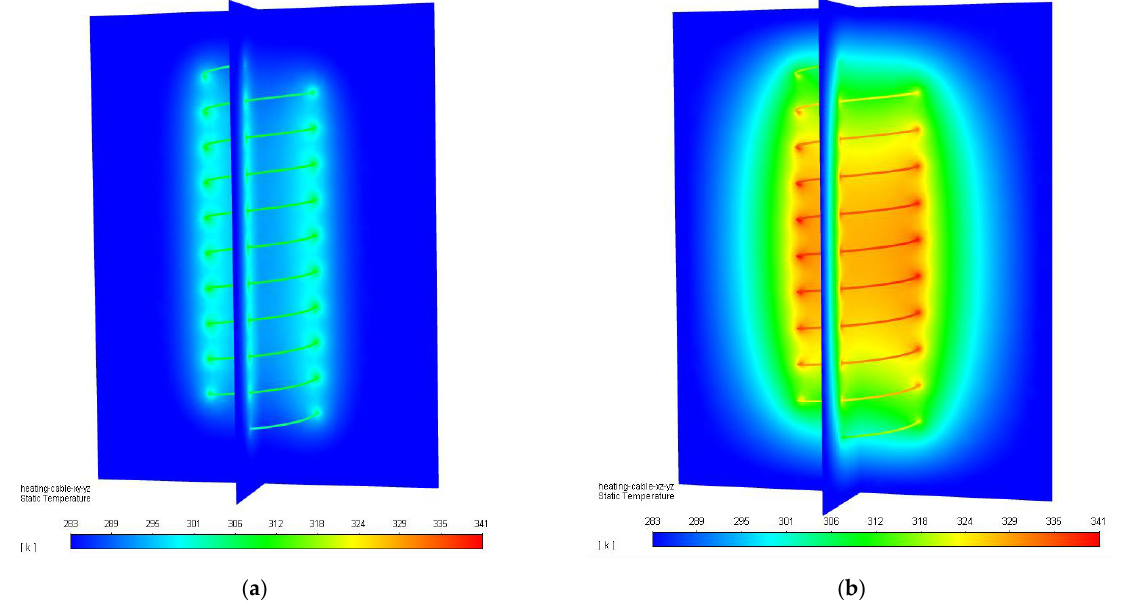
Figure 14. CFD simulation of the helix at t_start ( a ) and t_140h ( b